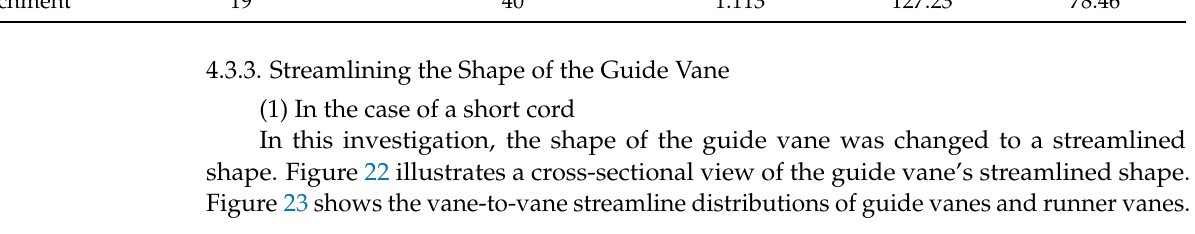
Figure 22. Changing the shape of guide vanes with short chords to make them streamlined.